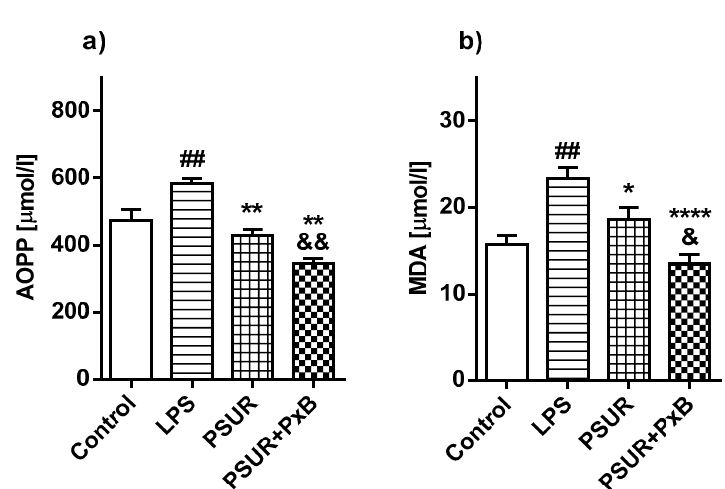
Figure 8. The values of ( a ) AOPP (Advanced Oxidation Protein Products) and ( b ) malondialdehyde (MDA) in lung tissue. Control vs. LPS ## p < 0.01; PSUR vs. LPS; PSUR + PxB vs. LPS * p < 0.05, ** p < 0.01, **** p < 0.0001; PSUR vs. PSUR + PxB & p < 0.05, && p < 0.01.